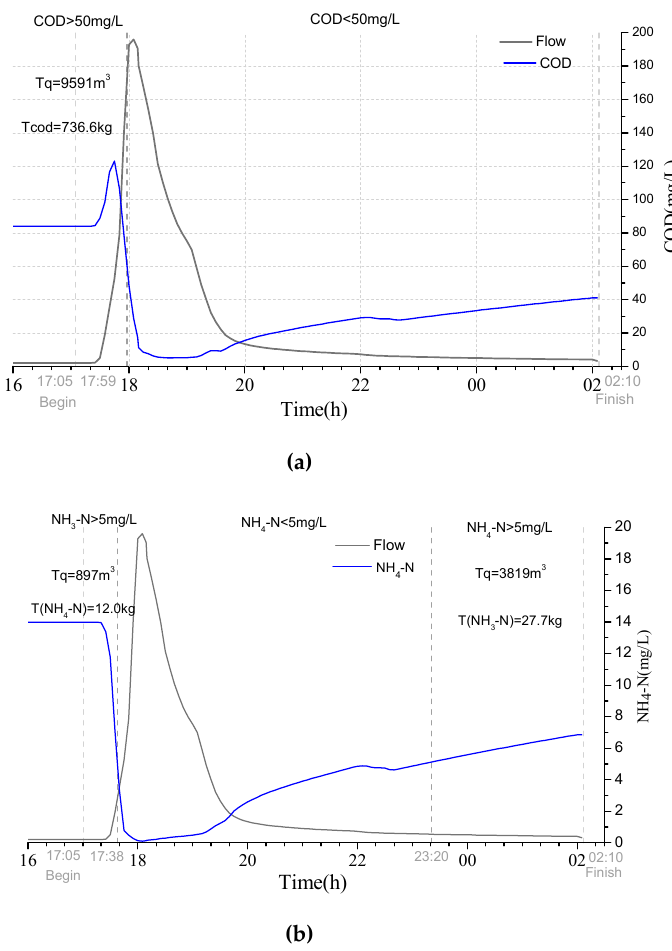
Figure 7. Process of COD ( a ) and NH 4 ‐ N ( b ) pollution with return period of 5 years.